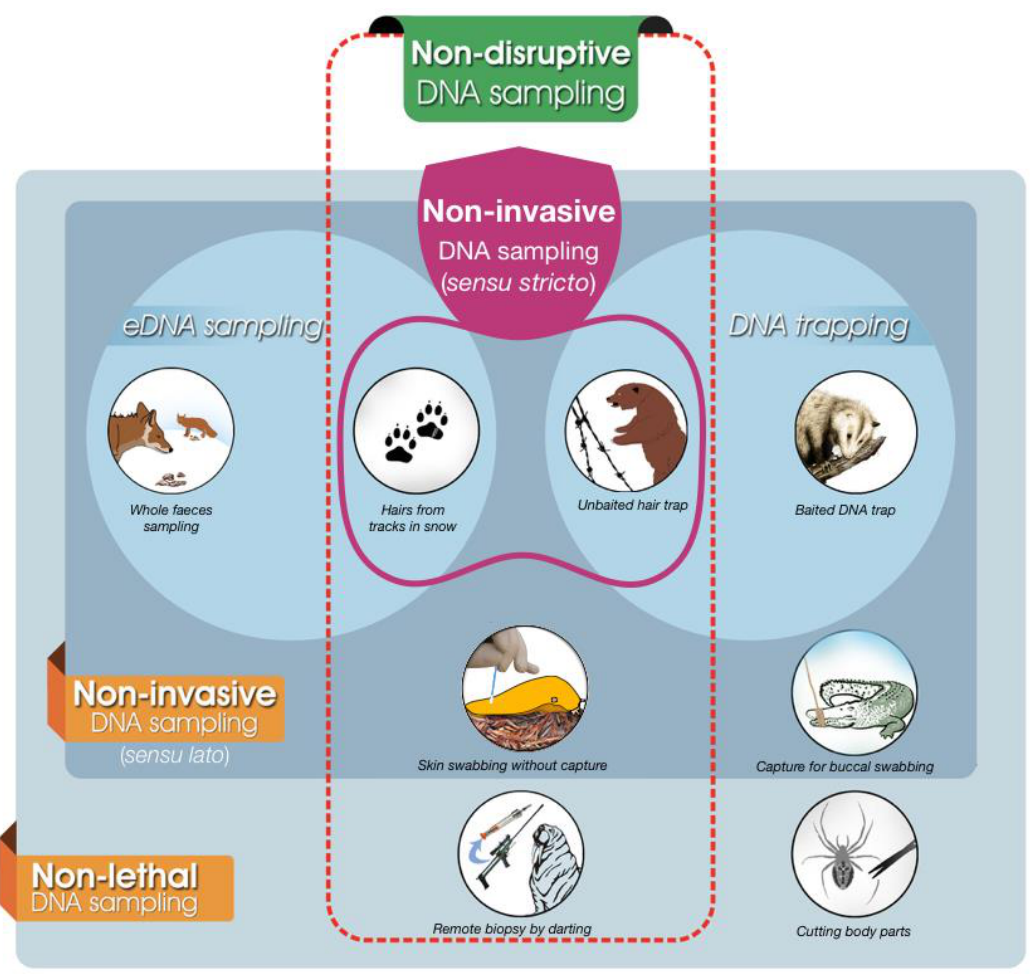
Figure 3 . The relationship between non-disruptive, non-invasive and non-lethal DNA sampling methods. Non-invasive DNA sampling sensu stricto corresponds to the definition given by Taberlet et al. (1999), Non-invasive DNA sampling sensu lato corresponds to the medical definition (Miller & Keane, 1983). Pictograms represent a non-exhaustive list of examples for which references are given below. From left to right and top to bottom: whole faeces sampling for species that use faecal territory marking (Modave et al. , 2017), hairs collected in snow (Cullingham et al. , 2016), hairs collected with unbaited barbed wire (Karamanlidis et al. , 2014), DNA trap baited to attract animals (Duenas et al. , 2015), skin swabbing in the field without capture (Morinha et al. , 2014), capture of reptiles for buccal